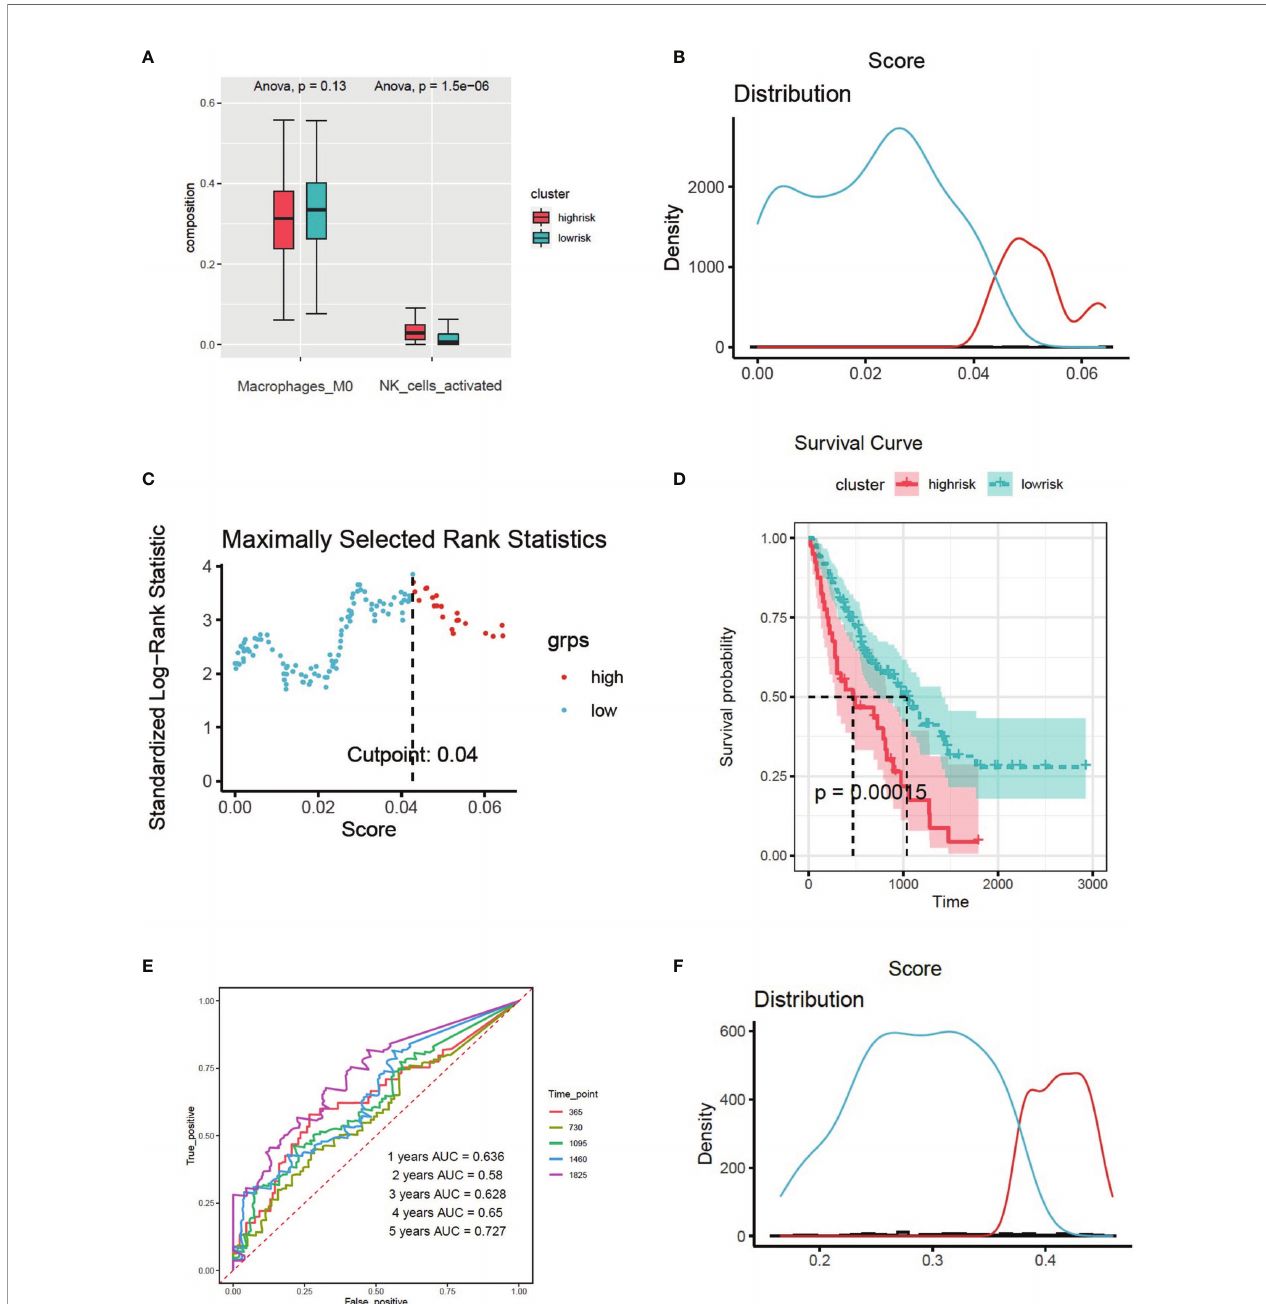
FIGURE 5 | (A) The in fi ltration of activated NK cells and M0 cells in two clusters based on the risk models of CX3CR1-related immune in fi ltration genes (Risk score2). (B) Histogram based on maximally selected rank grouping. (C) The cut-off point with the maximum standard log-rank statistic was marked with a vertical dashed line. (D) Kaplan – Meier plot of overall survival in two clusters based on the in fi ltration of activated NK cells (Risk score3). (E) The ROC curve in the risk models of activated NK cells (Risk score3). (F) Histogram based on maximally selected rank